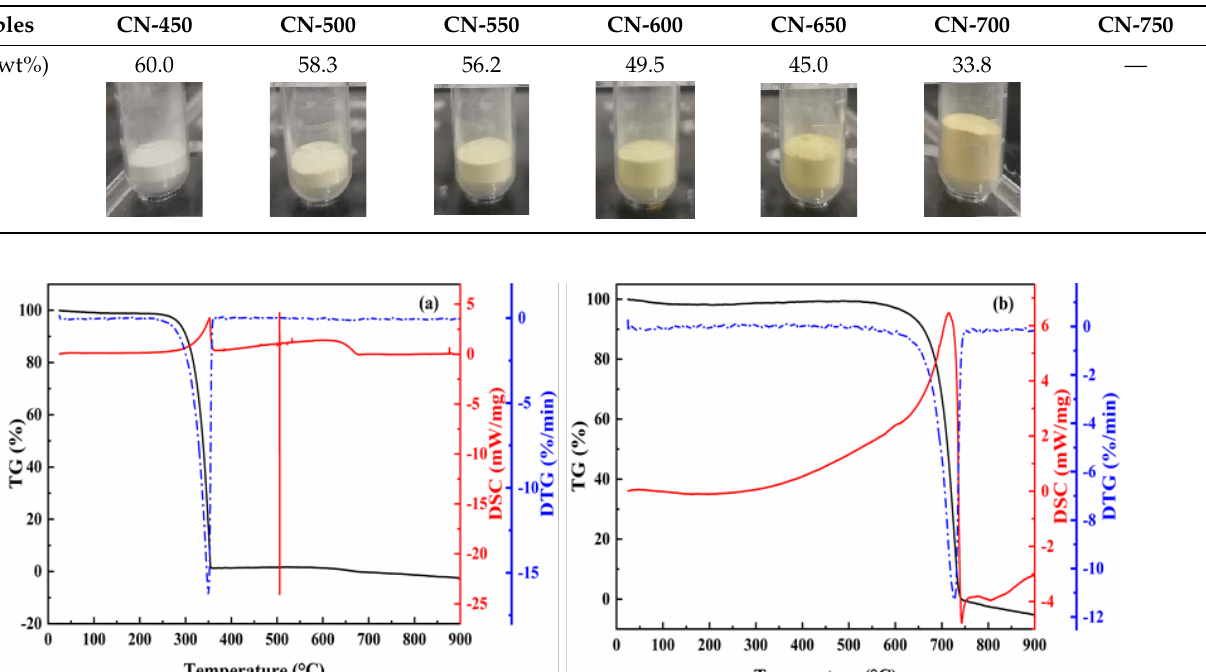
Table 1. Yield and color comparison of all samples.